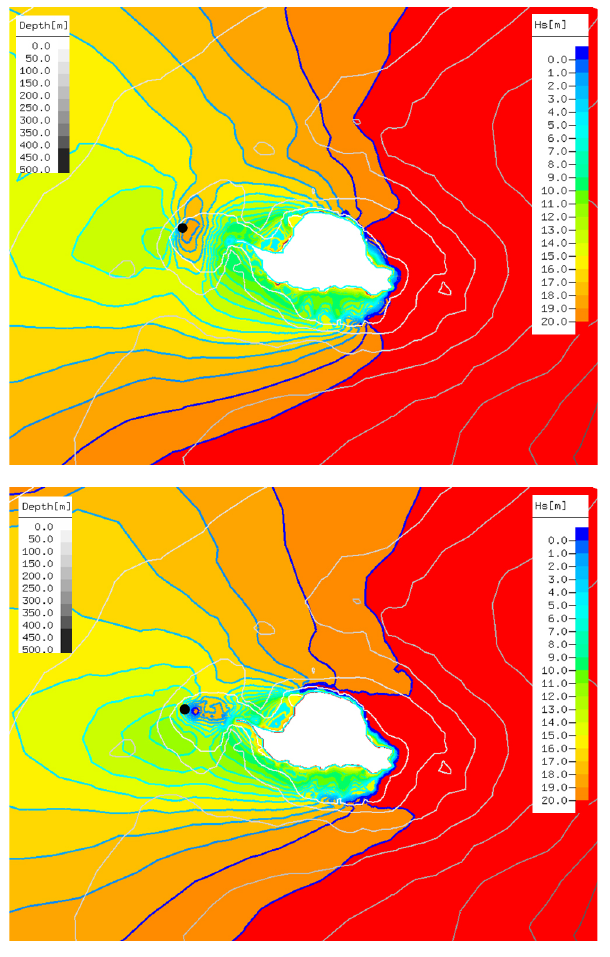
Fig. 10. As in Fig. 9, for constant wave-breaking coefficient of 1.5.